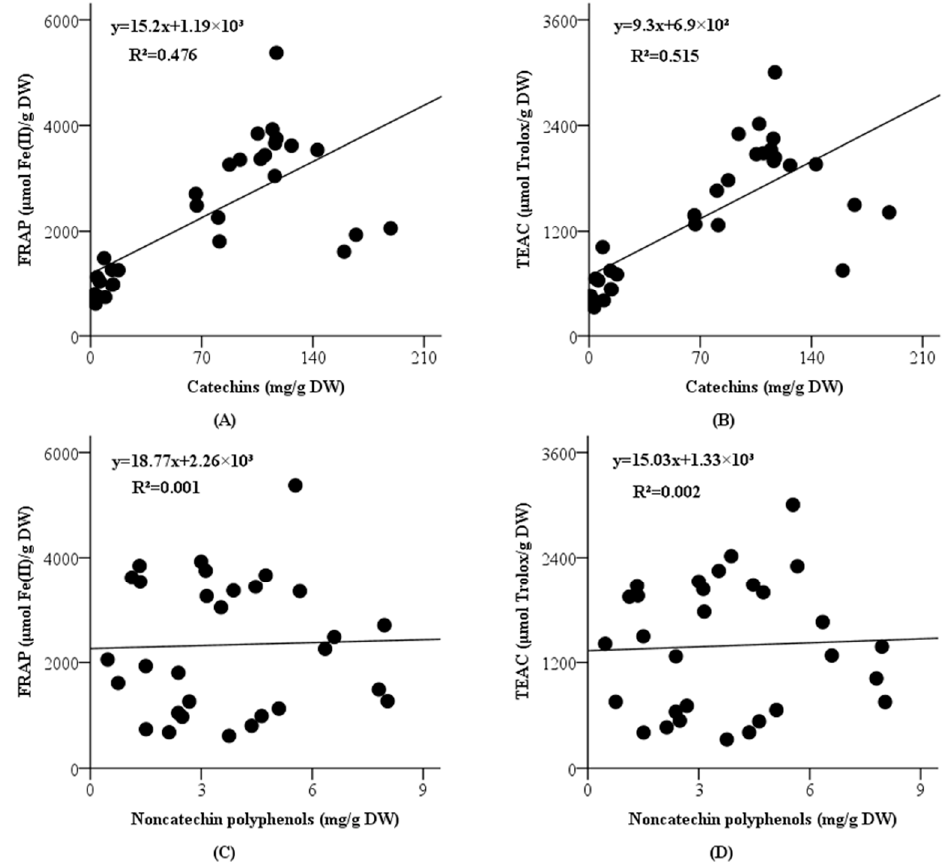
Figure 4. Correlations between FRAP and catechins ( A ), TEAC and catechins ( B ), FRAP and noncatechin polyphenols ( C ) and TEAC and noncatechin polyphenols ( D ). Abbreviations: FRAP, ferric-reducing antioxidant power; TEAC, Trolox equivalent antioxidant